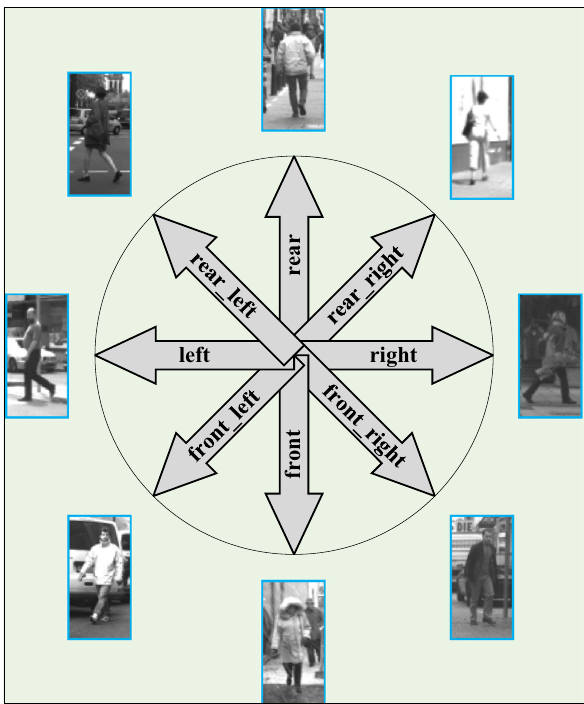
Fig. 9 PDC data set includes eight different pedestrian orientations